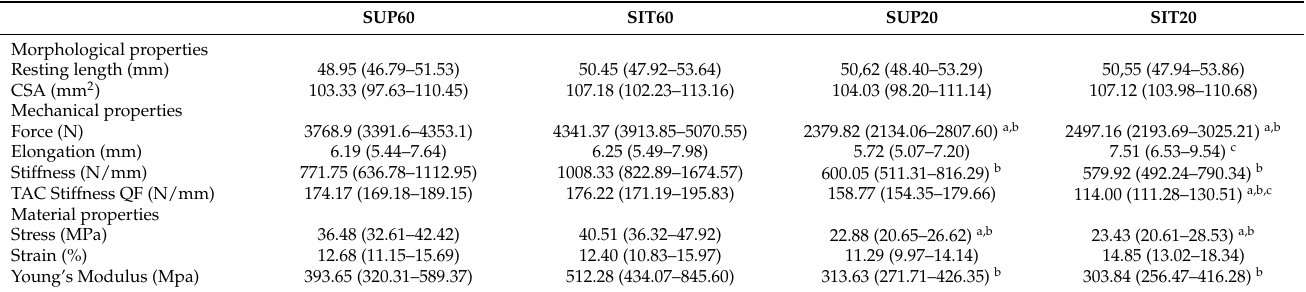
Table 1. Patellar tendon properties and tendon aponeurosis complex stiffness of quadriceps femoris at different hip and knee angles measured during maximal voluntary isometric contraction. Geometric mean (95%